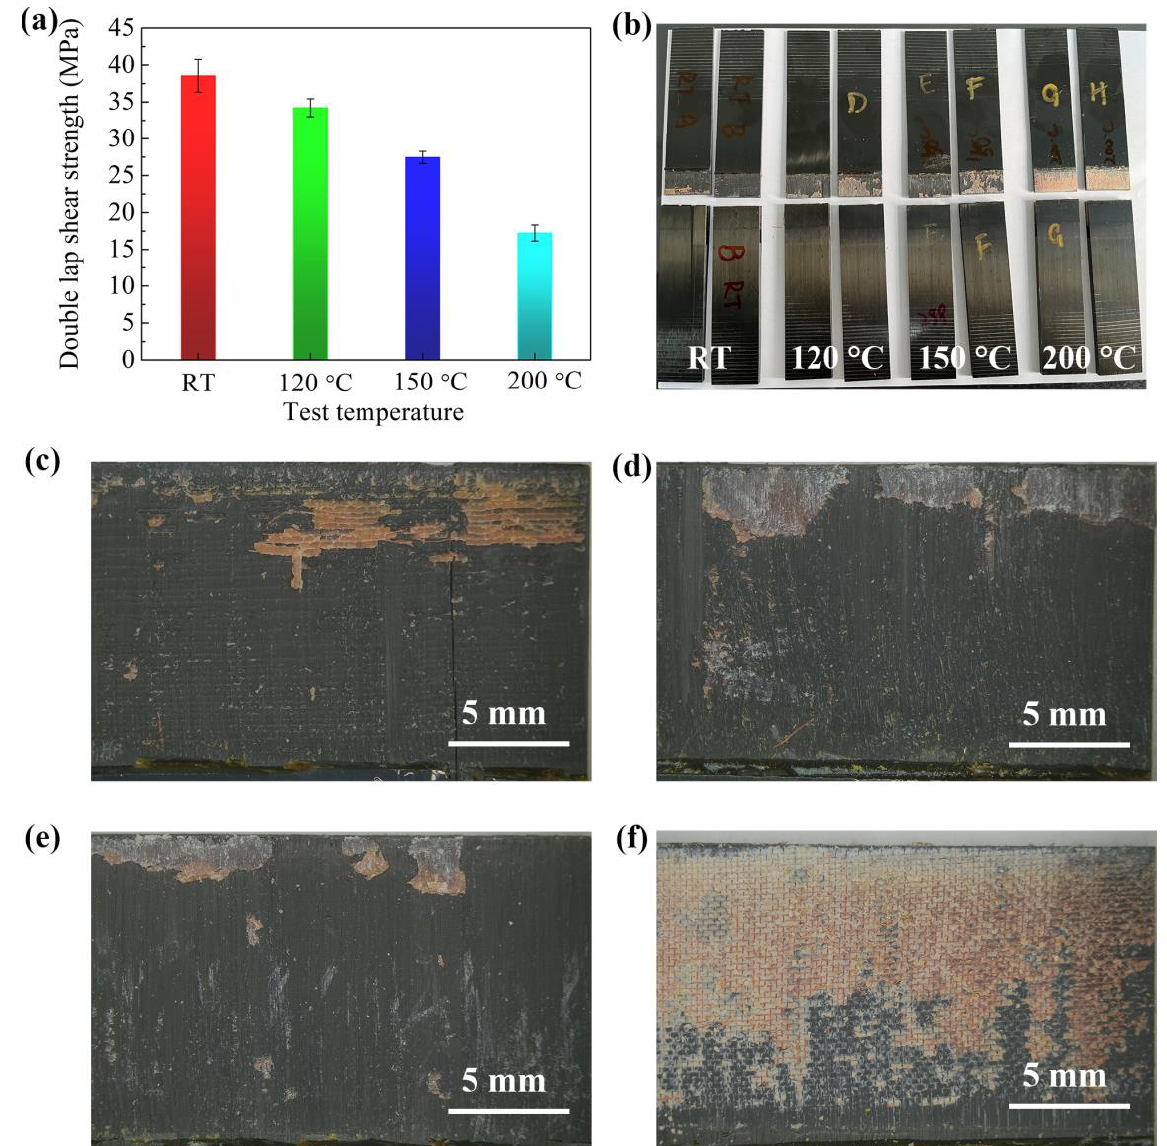
Figure 9. ( a ) Double lap shear strength of composite joints at different test temperatures. ( b ) Photos of composite joints after testing. The failure mode of the co-cured composite joints: ( c ) 23 °C; ( d ) 120 °C; ( e ) 150 °C; and ( f ) 200 °C.